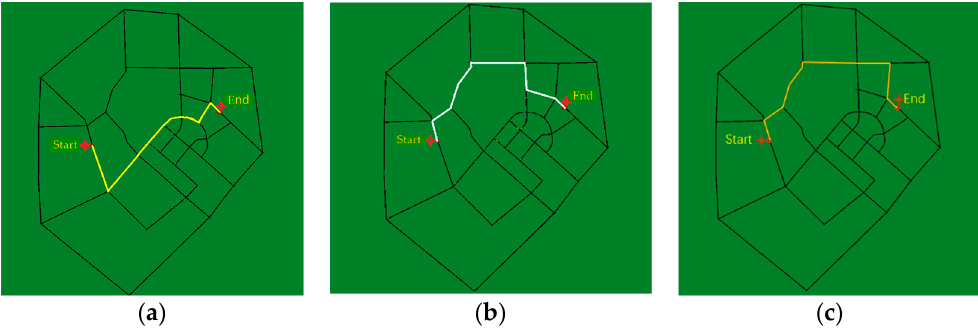
Figure 13. The optimal path results with different targets: ( a ) the shortest distance-based optimal path; ( b ) the energy saving-based optimal path; ( c ) the time saving-based optimization path. Table 8. The optimal results for different optimization conditions.